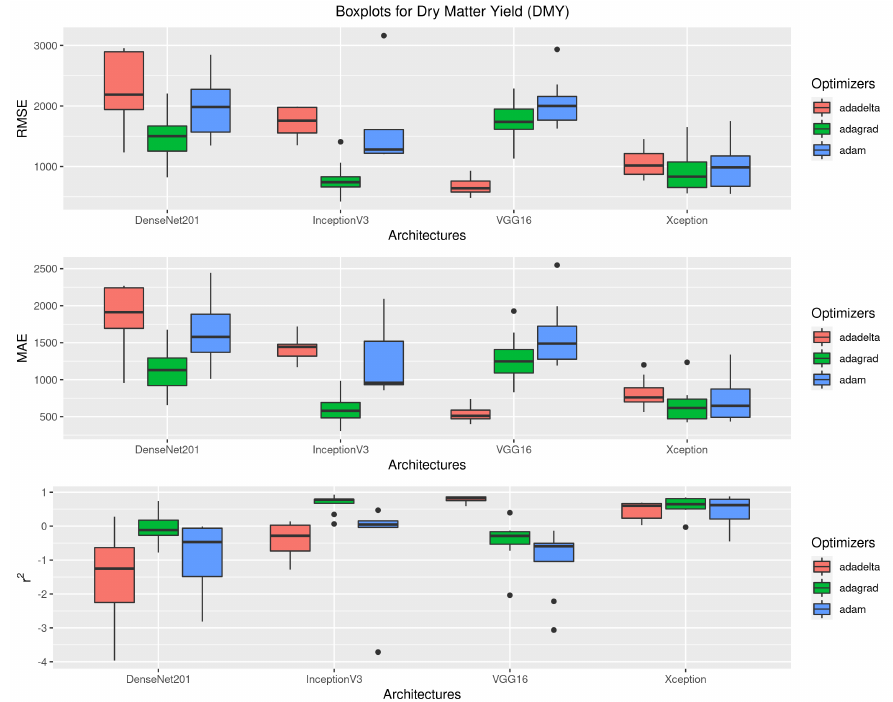
Figure 3. Dry matter yield root mean squared error (RMSE) [kg DM/ha], mean absolute error (MAE) [kg DM/ha] and coefficient of determination ( r 2 ) boxplots for all 4 architectures (DenseNet201, InceptionV3, VGG16 and Xception) and the 3 optimizers (Adadelta, Adagrad and Adam) used. The data came from the 8 runs (i.e., 8 cross-validation folds) of each configuration (architecture+optimizer) over the DMY test set. To improve the readability, 3 extreme outliers (RMSE > 10.000 kg DM/ha) for InceptionV3 optimized by Adam have been